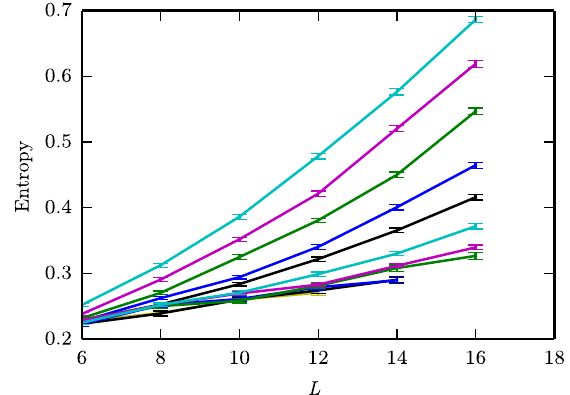
FIG. 7. The bipartite entanglement entropy for a center cut as a function of system size L in the strong disorder limit, as obtained by IQPE to accuracy (from top to bottom) k ¼ 10 ; 11 ; … ; 20 . As the accuracy is increased, and the state begins to approach an energy eigenstate, the entanglement entropy